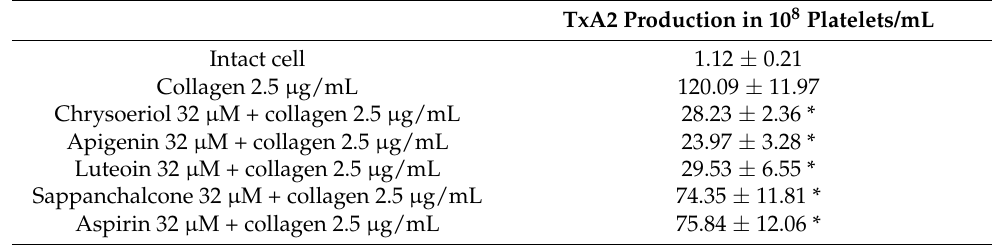
Table 4. Effects of four key components on TxA2 production in human